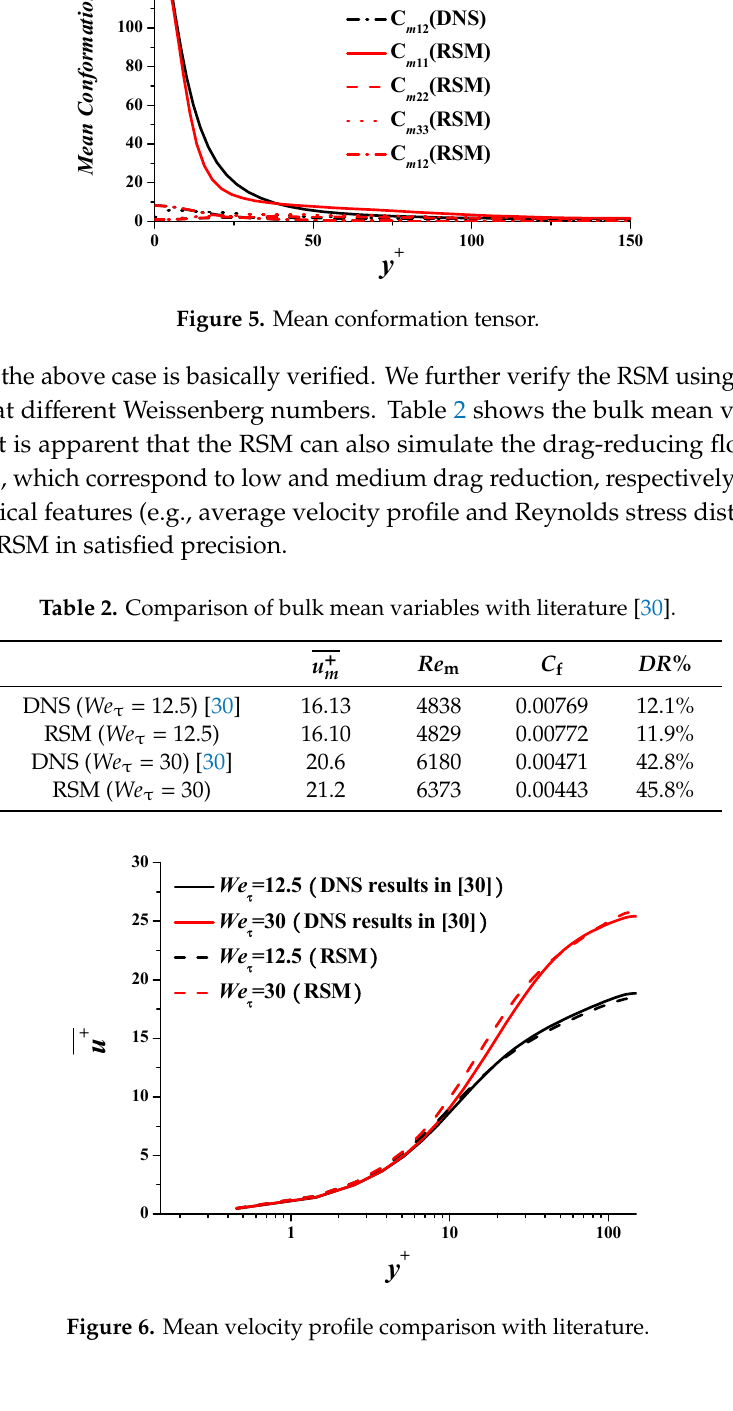
Figure 7. Reynolds shear stress comparison with literature. RSM only concerns time-average variables so that it does not need to resolve the small eddies near the walls like DNS. The complex and time-consuming numerical methods, such as numerous iterations of pressure, can be avoided. Therefore, the computational time of RSM can be much smaller than that of DNS. Table 3 verifies that RSM can largely save the computational time because the acceleration ratio of computational time of DNS and RSM is as high as 120,960. Table 3. Computational time. DNS